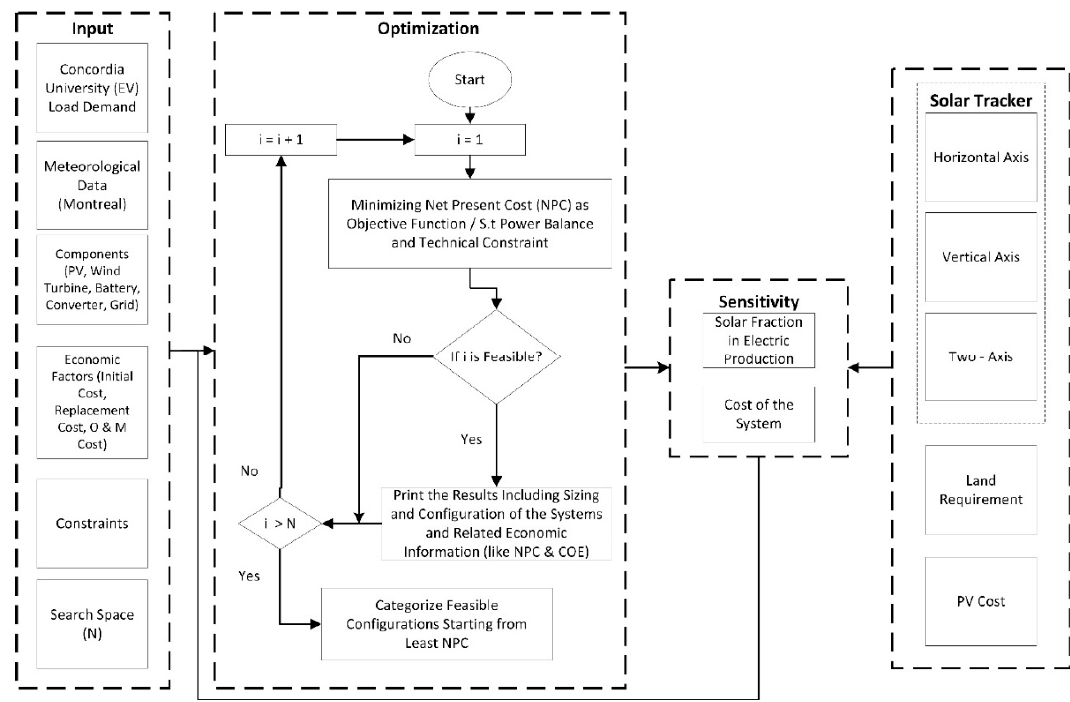
Figure 1. Schematic of the sizing and ranking process for each configuration scenario .